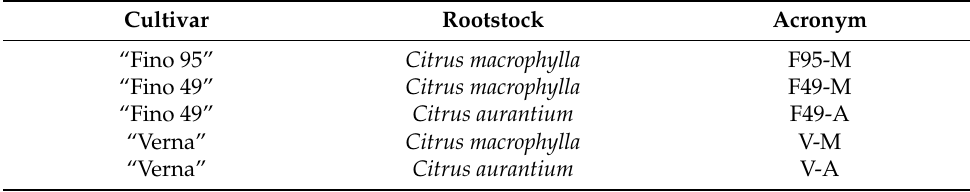
Table 1. Varieties and rootstocks studied in this